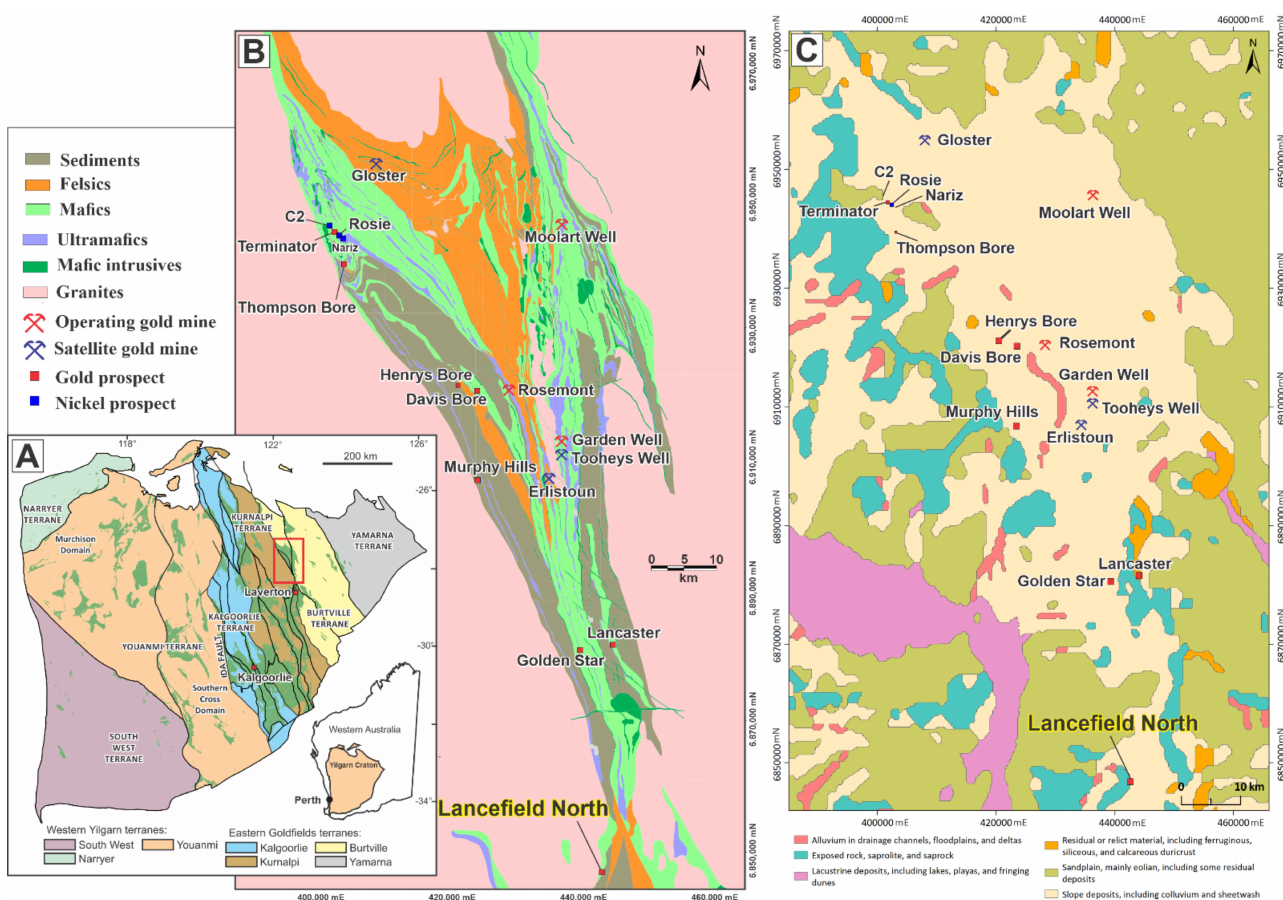
Figure 1. ( A ) The tectonic map of the Yilgarn Craton (bottom left) shows the location of the Duketon Greenstone Belt in the Burtville Terrain. ( B ) A geological map of the Duketon Greenstone Belt showing the main geological units, Au mines, and Ni resources (Rosie, Nariz, and C2). The map is provided by Duketon Mining Ltd. ( C ) A regolith map (Geological Survey of Western Australia, 1:500,000) showing the distribution of the Cenozoic cover over the Duketon Greenstone Belt. The Permian cover is not outcropped in the